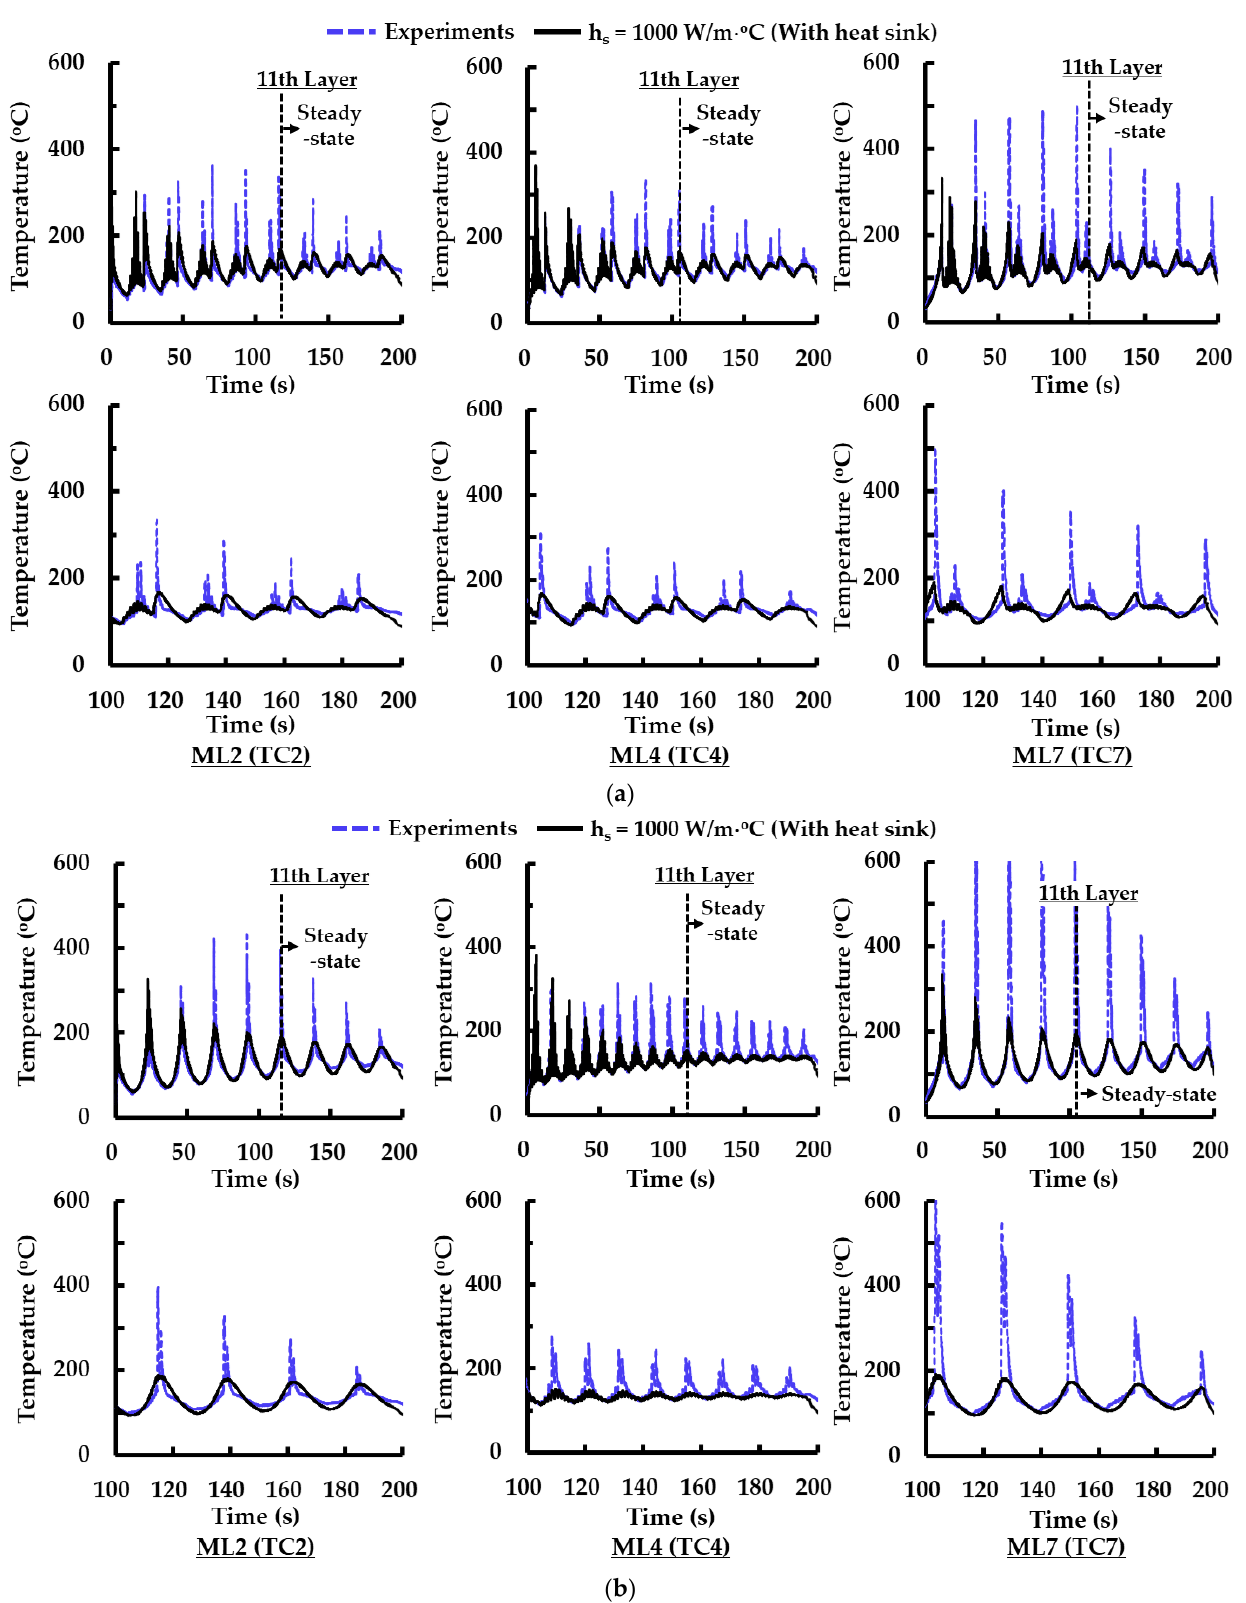
Figure 8. Comparison of temperature histories of experiments and those of FEAs for a large volume deposition (deposition of seventeen layers): ( a ) type 2 path for ADDS; ( b ) type 5 path for ADDS.